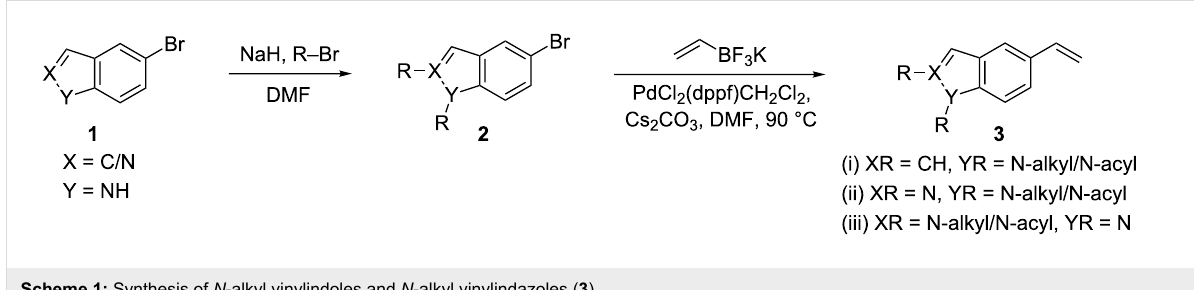
Scheme 1: Synthesis of N -alkyl vinylindoles and N -alkyl vinylindazoles ( 3